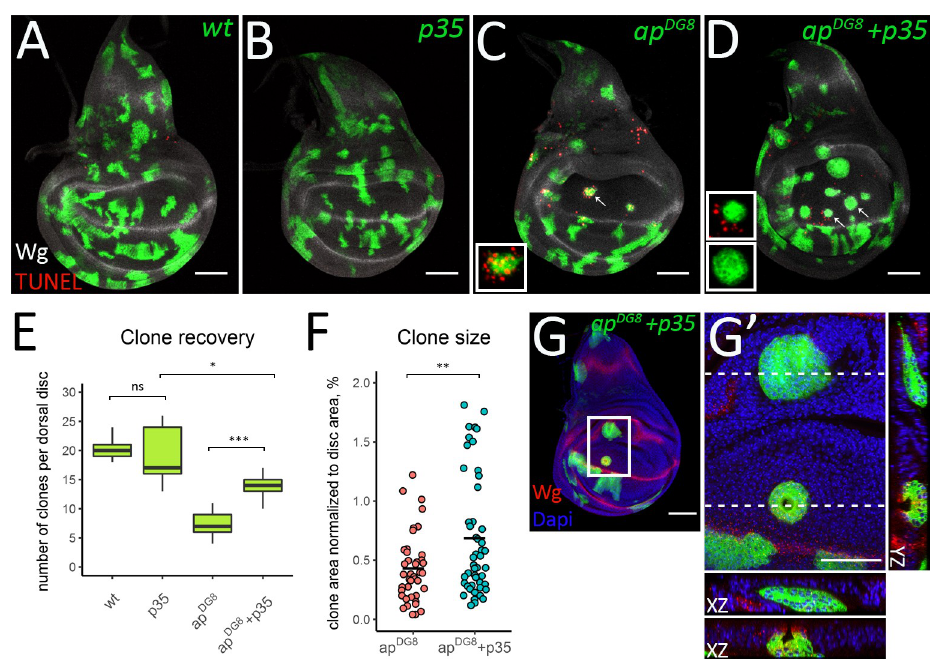
Fig 5. In the absence of apoptosis misspecified clones become bigger and undergo extrusion. (A-D) Third instar wing discs with wild-type (A), p35 -expressing (B), ap DG8 (C) and ap DG8 p35 -expressing clones. The insets in C and D show enlarged images of single representative clones defined by arrows. (E) Clone recovery in the dorsal disc. 9 discs for each genotype were analyzed. (F) Plot shows areas of ap DG8 and ap DG8 p35 -expressing clones. (G-G’) ap mutant clones are eliminated from the dorsal pouch via extrusion when apoptosis is blocked. (G) Third instar wing disc containing ap DG8 p35- expressing clones. (G’) Zoom-in of the region defined by the white square in G. The XZ and YZ cross-sections throughout the clones located in the hinge and in the pouch are shown (XZ orientation: the apical side– up; YZ orientation: the apical side—left). Scale bars represent 50 μ m.